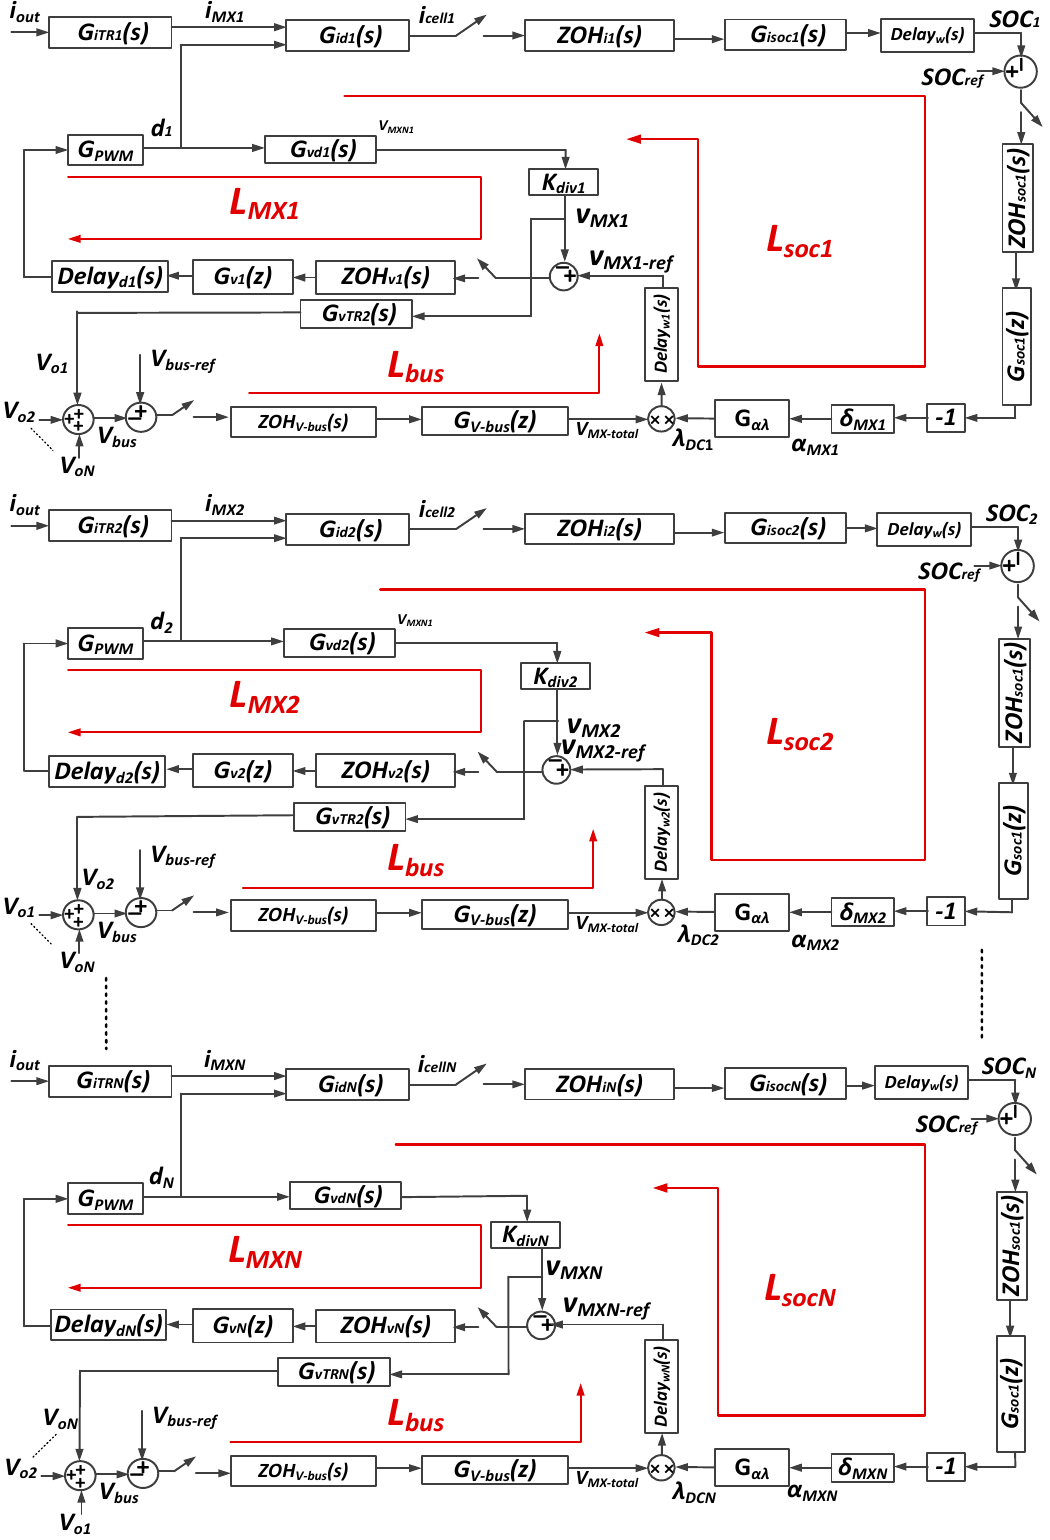
Figure 3. Small-signal of distributed the WEDES battery system with the WEDES controller.